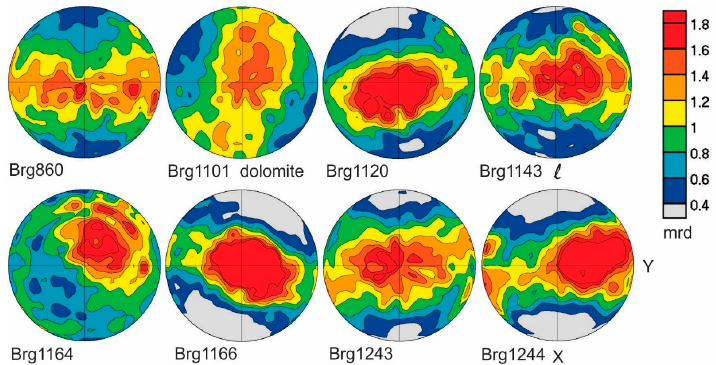
Figure 10. Neutron pole figures 0001 of calcite and dolomite in Triassic marbles. Equal area projection on the schistosity plane. Lineation is l . All samples are calcite except Brg1101 which is dolomite. Table 2. EBSD twin boundary statistics. See also Table S2. The data in the table are obtained from the sum over individual scans. Selected data and twin boundaries are in